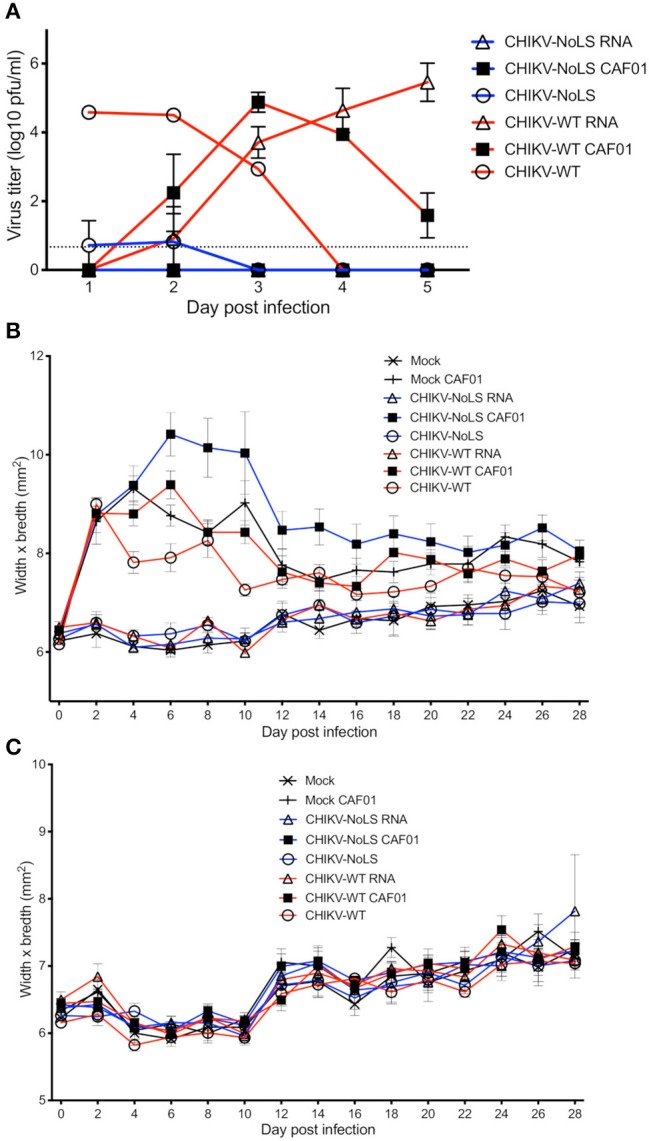
Viremia following CHIKV-NoLS CAF01 inoculation and CAF01 induced footpad swelling in C57BL/6 mice. C57BL/6 mice were inoculated with viable virus particles (104 pfu CHIKV-WT or CHIKV-NoLS), CAF01 delivered RNA (2 μg CHIKV-WT or CHIKV-NoLS RNA complexed with 0.3 mg CAF01) or RNA alone (2 μg CHIKV-WT or CHIKV-NoLS RNA) subcutaneously in the ventral/lateral side of the right foot. Mock inoculated mice received 20 μl VP-SFM media alone or VP-SFM media containing 0.3 mg CAF01. (A) Serum was collected on days 1–5 post inoculation and virus titrated by plaque assay. Mice were monitored daily for signs of CHIKV-induced footpad swelling in the (B) ipsilateral (inoculated) and (C) contralateral (non-inoculated) foot. Each symbol represents the mean ± standard error from five to six mice.